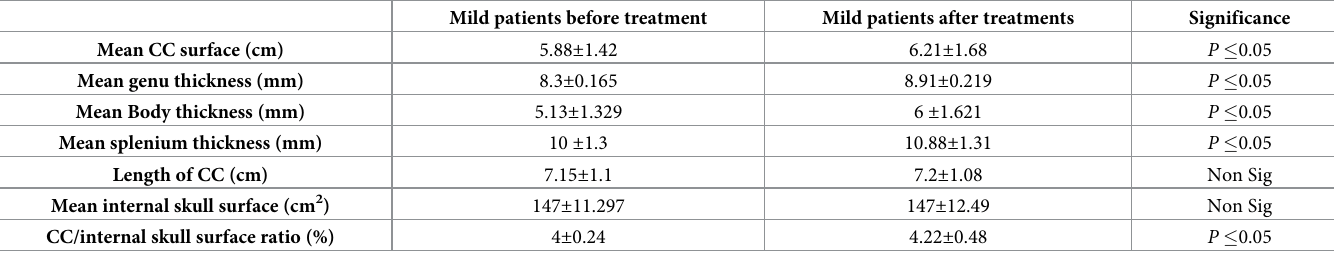
Table 4. Average CC values in mild Alzheimer disease patients: Before and after the treatment. Mild patients before treatment Mild patients after